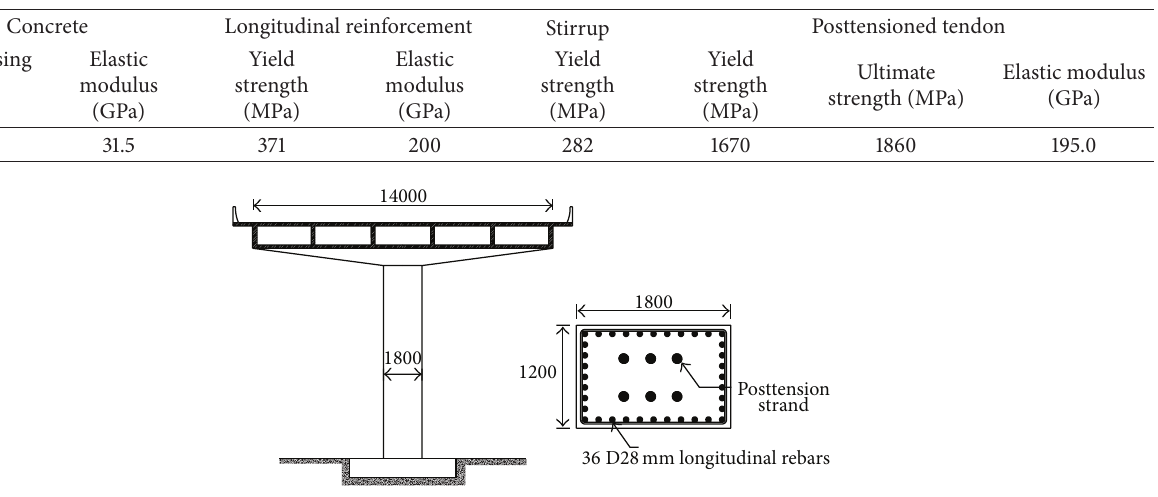
Table 1: Material property of the bridge structure.